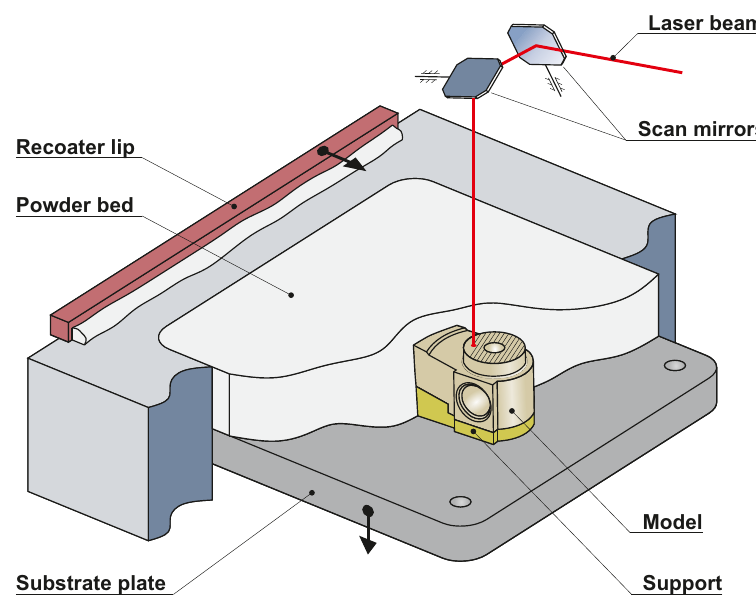
Figure 6. Schematic representation of the Selective Laser Melting